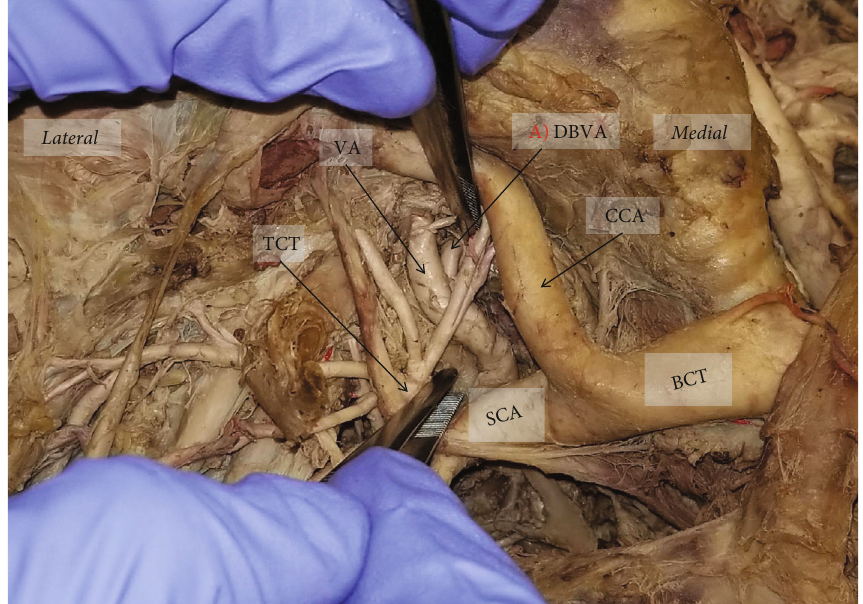
Figure 5: Right subclavian artery and presence of descending branch of the vertebral artery: (a) descending branch of the vertebral artery from its origin. TCT: thyrocervical trunk; VA: vertebral artery; DBVA: descending branch of the vertebral artery; SCA: subclavian artery; CCA: common carotid artery; BCT: brachiocephalic